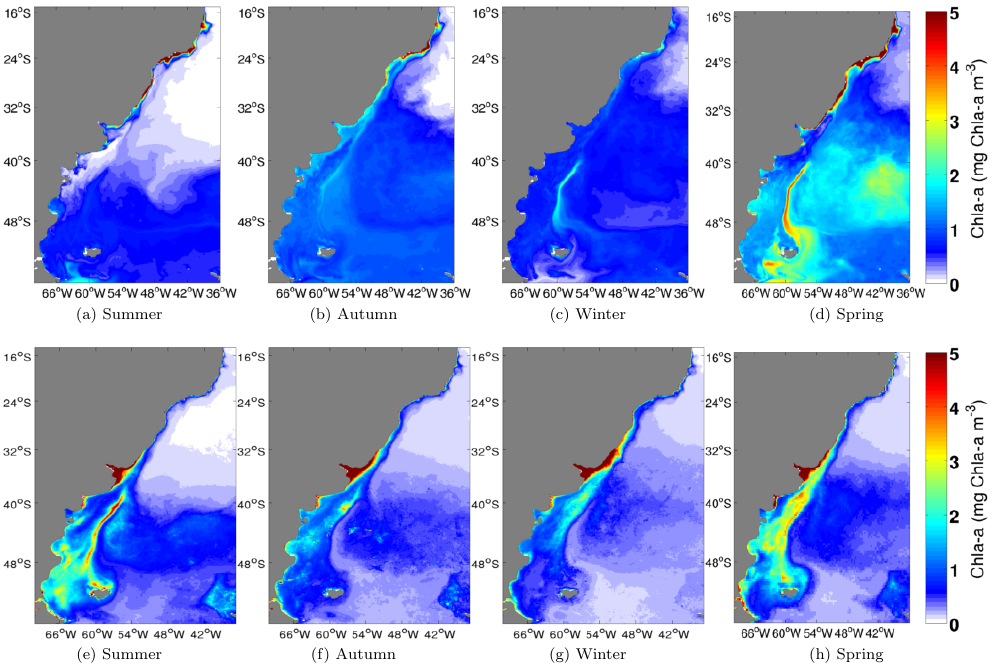
Figure A2. Seasonal climatology of modeled chlorophyll a concentration mgChl a m − 3 – 4 years average (upper row), and climatology from Aqua-Modis sensor – from 2003 to 2013 (lower